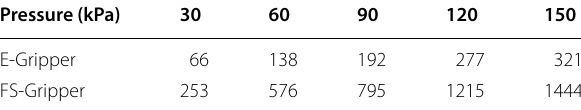
Table 1 Relative difference of bending angles of each